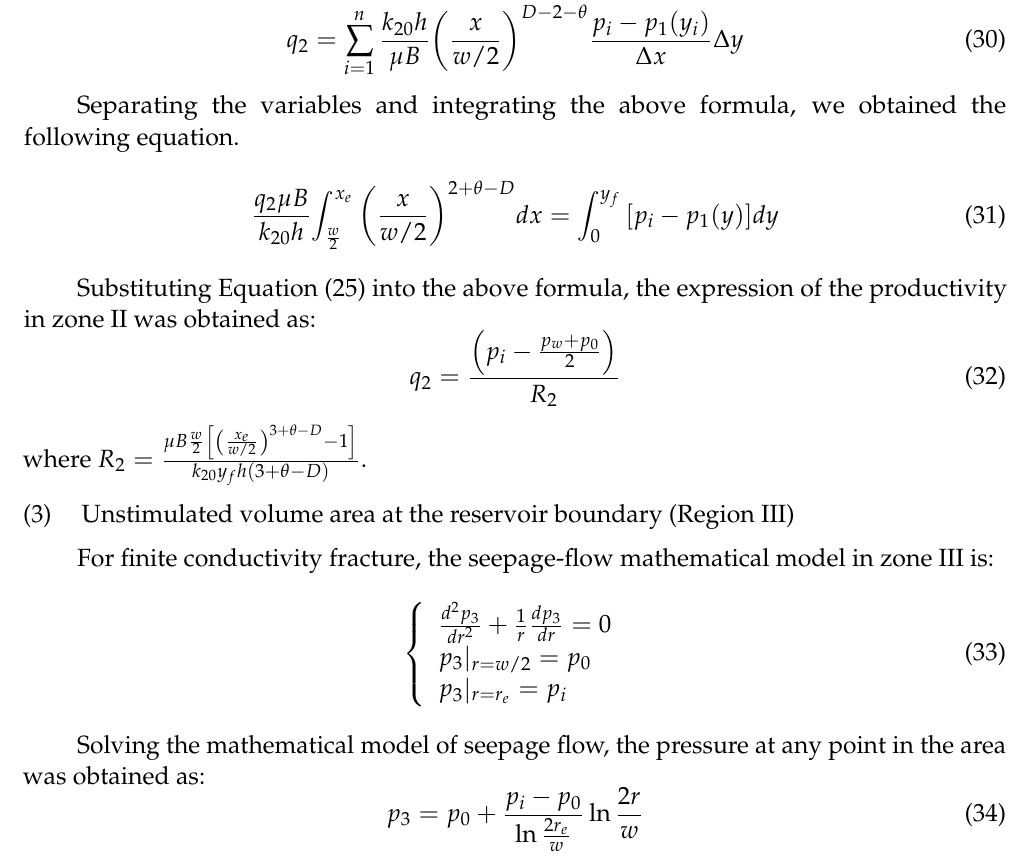
Figure 6. Plane figure of fluid flow in stimulated fracture network volume area.